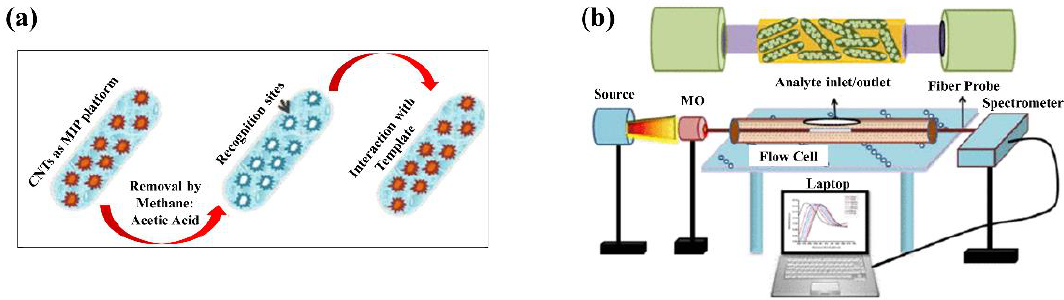
Figure 6. A schematic illustration of fabrication and testing process for fiber-optic sensors; (a) formation of surface imprinted sites on carbon nanotubes (CNTs), and (b) experimental set-up for dopamine sensing. An optical fiber of core diameter 600 um and NA 0.4 is uncladded from the middle 1 cm length and coated with 40 nm silver film for excitation of SPR. Surface imprinted CNTs suspensions were prepared by vinyl group and molecular imprinted polymers (MIPs) for sensing probe. This entrapment of dopamine molecules in the imprinted cavities on CNTs results in increase in the refractive index of CNTs layer. The figure in Pathak and Gupta [54] is reprinted with permission from Institute of Electrical and Electronics Engineers (IEEE).